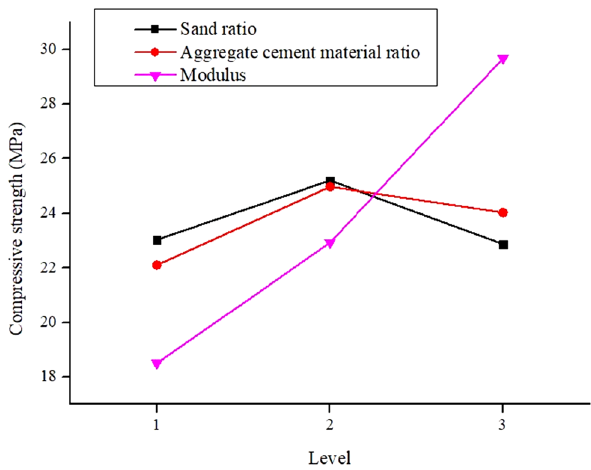
Figure 13: Trend chart of each factor level.